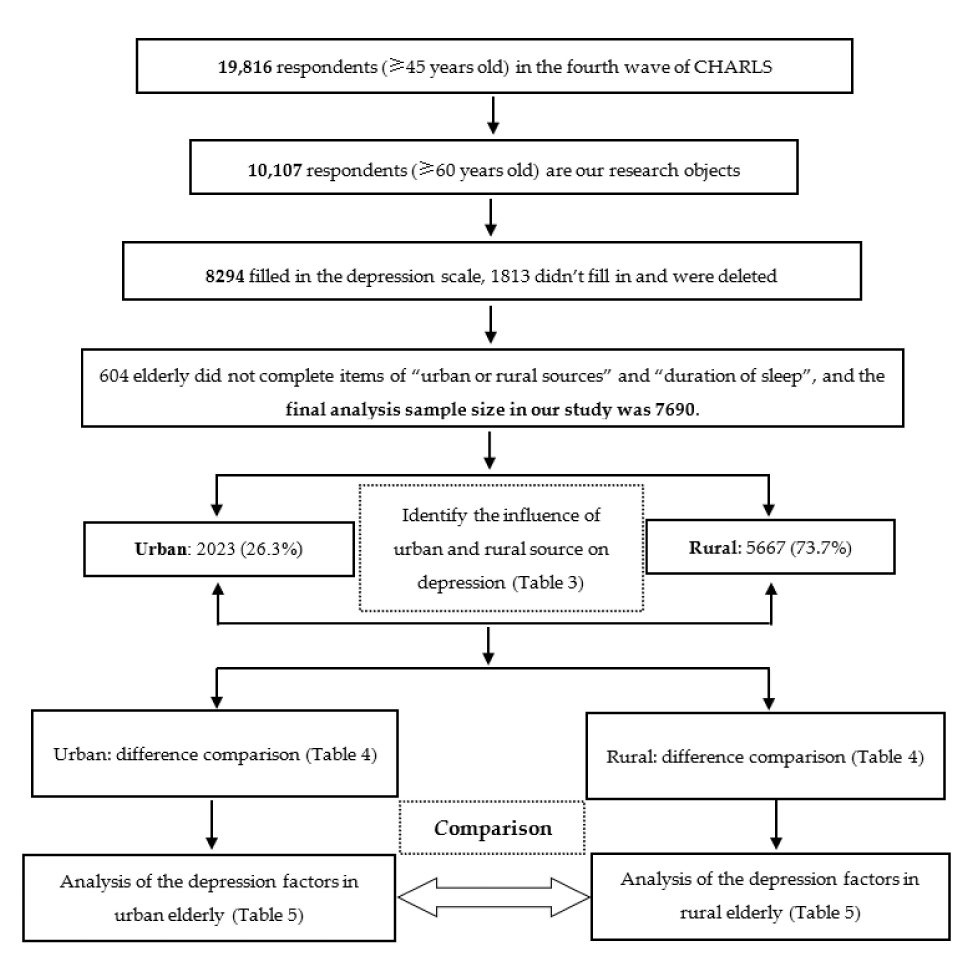
Figure 1. The flowchart of this